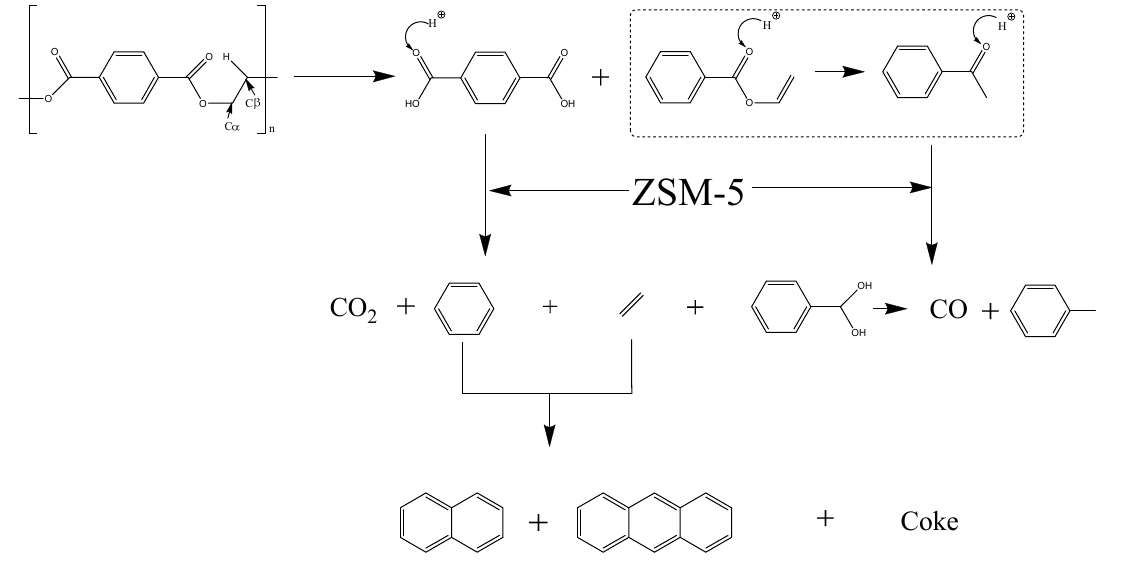
Figure 9. Possible decomposition pathways of PET pyrolysis .